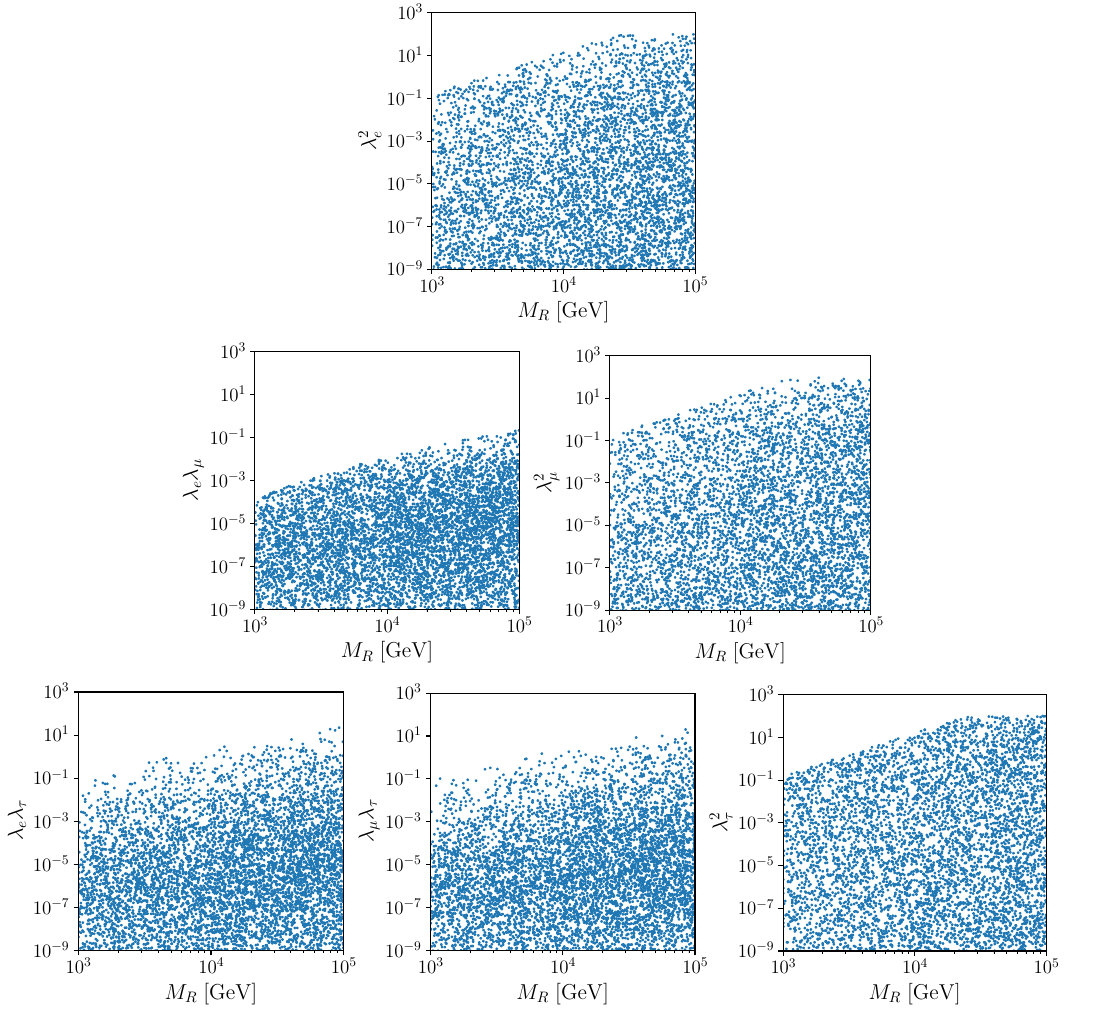
Figure 11. Allowed points for the possible products λ i λ j , i, j ∈ { e, µτ } (see eq. (2.15)) as a function of M R